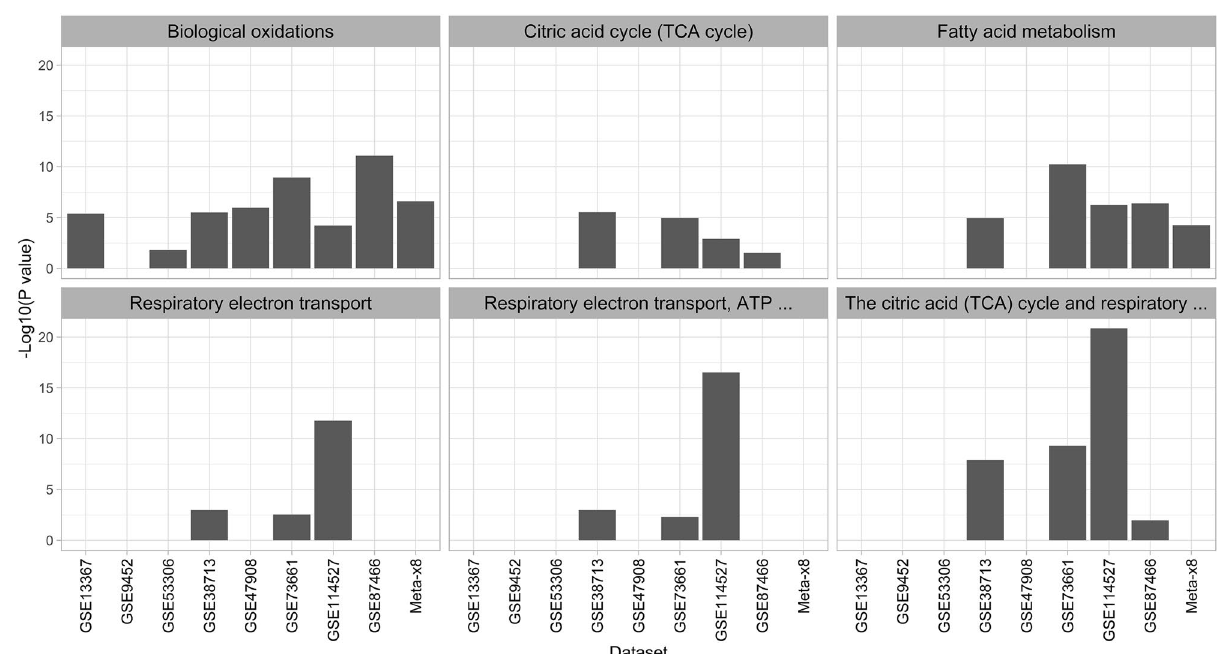
Figure 4. Enrichment of transport and modification-related Reactome pathways in individual dataset and meta-analysis (Meta- × 8) down-regulated genes. The − log10 of the adjusted P value is shown on the Y-axis with higher bars representing lower adjusted P